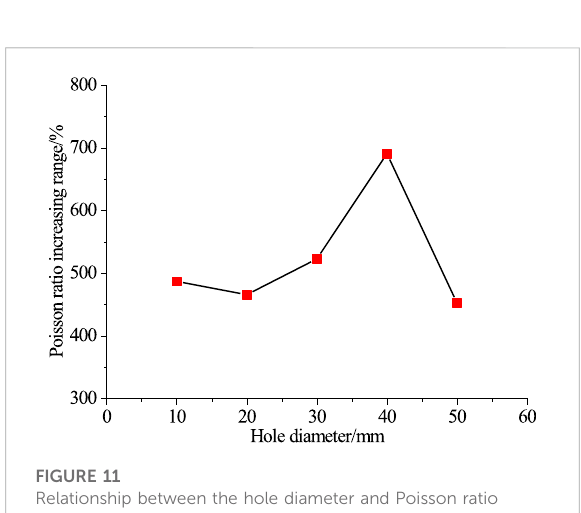
Relationship between the hole diameter and Poisson ratio increasing